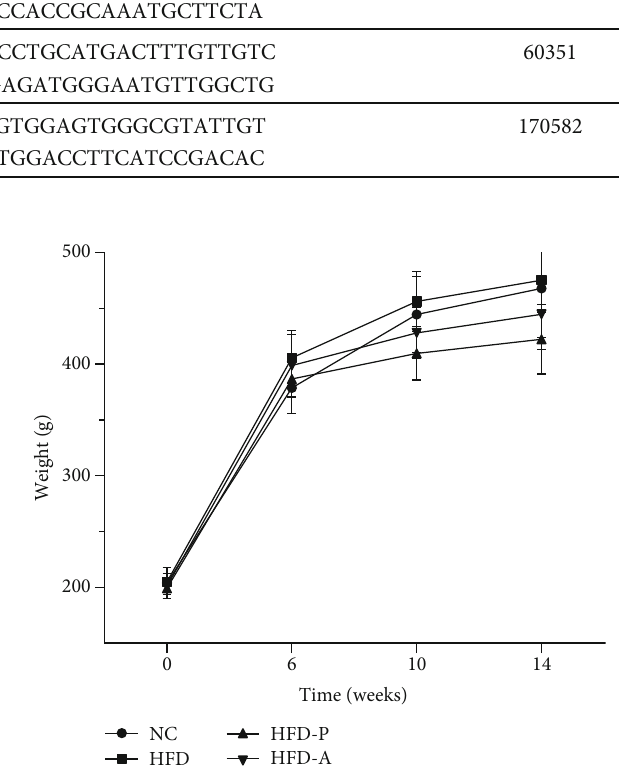
Figure 1: Changes in body